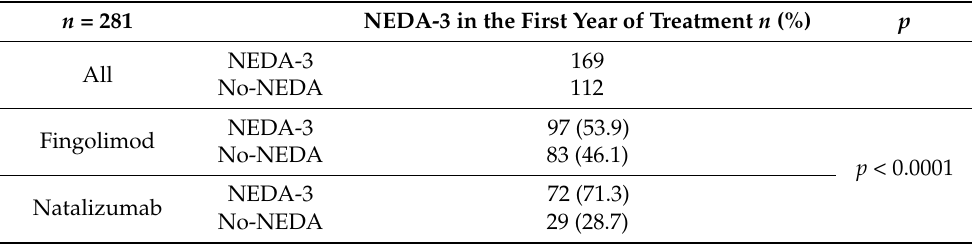
Table 3. NEDA-3 for fingolimod and natalizumab in the first year of treatment for patients that began the treatment in 2013 and 2014.